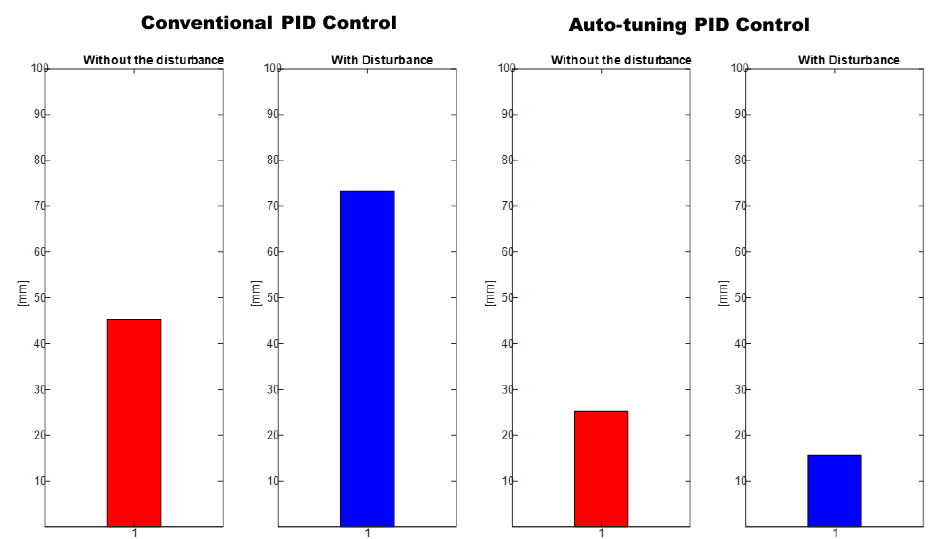
Figure 19. RMSE: Conventional PID Controller ( left ) vs. auto-tuning PID ( right ).